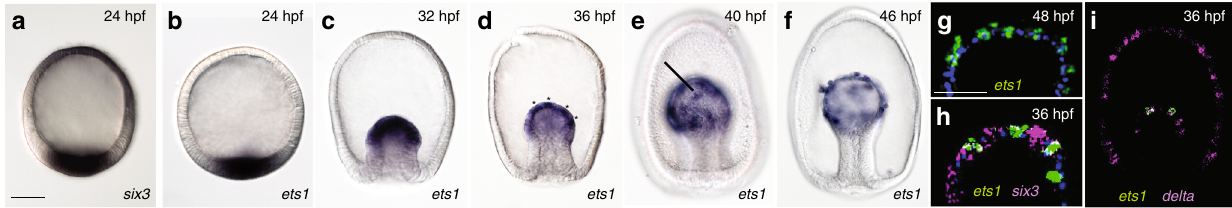
Fig. 3 Segregation of mesodermal subtypes into interleaved cells by 36 hpf. Sea star ets1 and six3 transcripts are co-expressed in the vegetal mesoderm of blastula stage embryos ( a , b ) at 24 h post fertilization (hpf). The expression of the ets1 transcript was assessed every 2 h from the onset of gastrulation by colorimetric WMISH. At 32 hpf the expression of ets1 is uniform throughout the mesoderm ( c ). At 36 hpf there is a discontinuity in the expression of ets1 transcript ( d , asterisks). Patches of ets1 expression become more distinct by 40 – 42 hpf ( e , line), and ets1 expressing cells start to ingress beginning at 46 hpf ( f ). Cells expressing ets1 transcript (green) at the tip of the archenteron are adjacent to cells with no detectable ets1 expression ( g ), using fl uorescent WMISH with a DAPI counterstain (blue), and are interleaved by cells expressing six3 transcript (magenta) ( h ). Cells expressing ets1 transcript also express the transcript encoding the Delta ligand ( i ). Data are representative of two biologically independent experiments consisting of at least ten embryos each. Scale bars represent 50 μ m; scale bar in ( a ) applicable to ( a – f ) and ( i ), scale bar in ( g ) applicable in ( g – h ), which show a magni fi ed region at the tip of the archenteron.